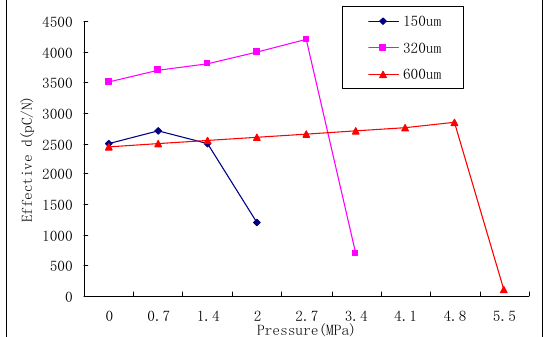
Figure 20. Influence of cavity depth.